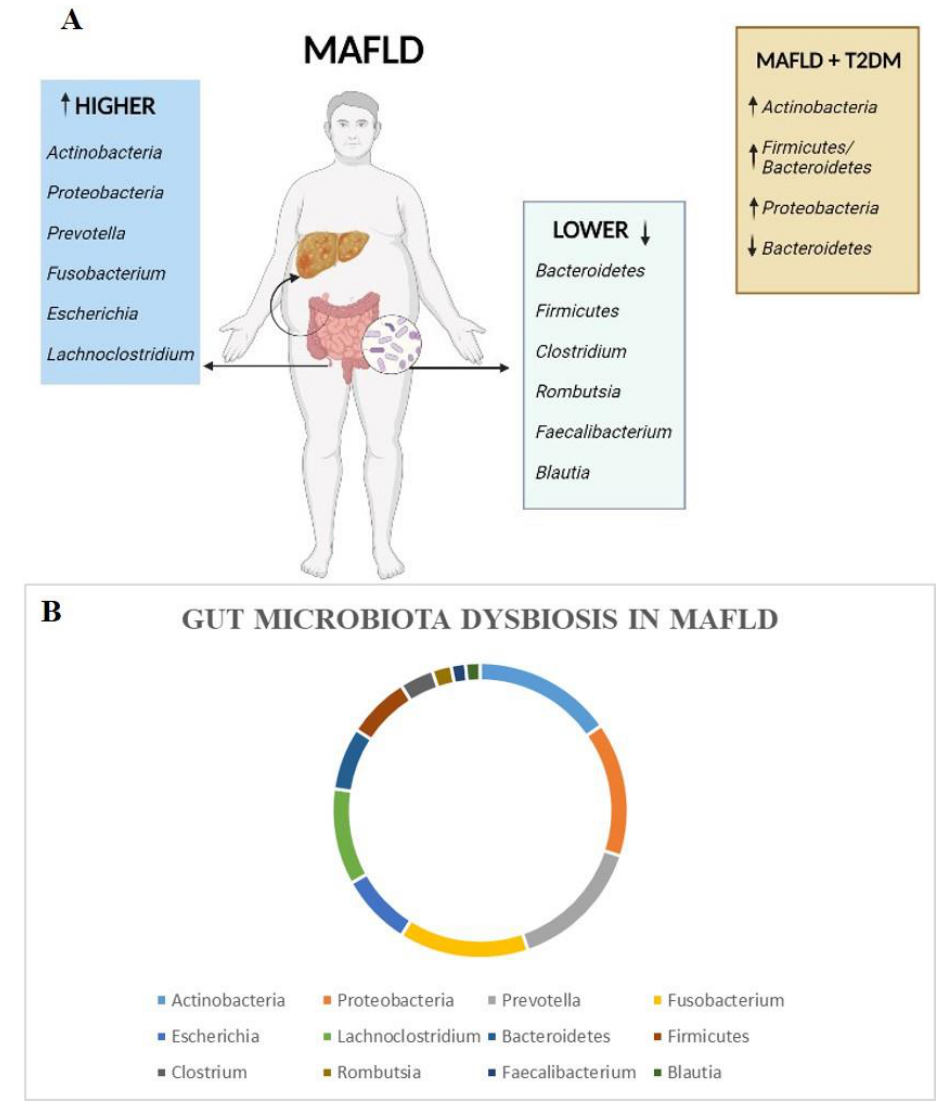
Figure 2. Schematic representation of gut microbiota dysbiosis in MAFLD patients (light blue and green boxes; panel ( A , B )) and MAFLD + T2DM patients (orange box; panel ( A )).